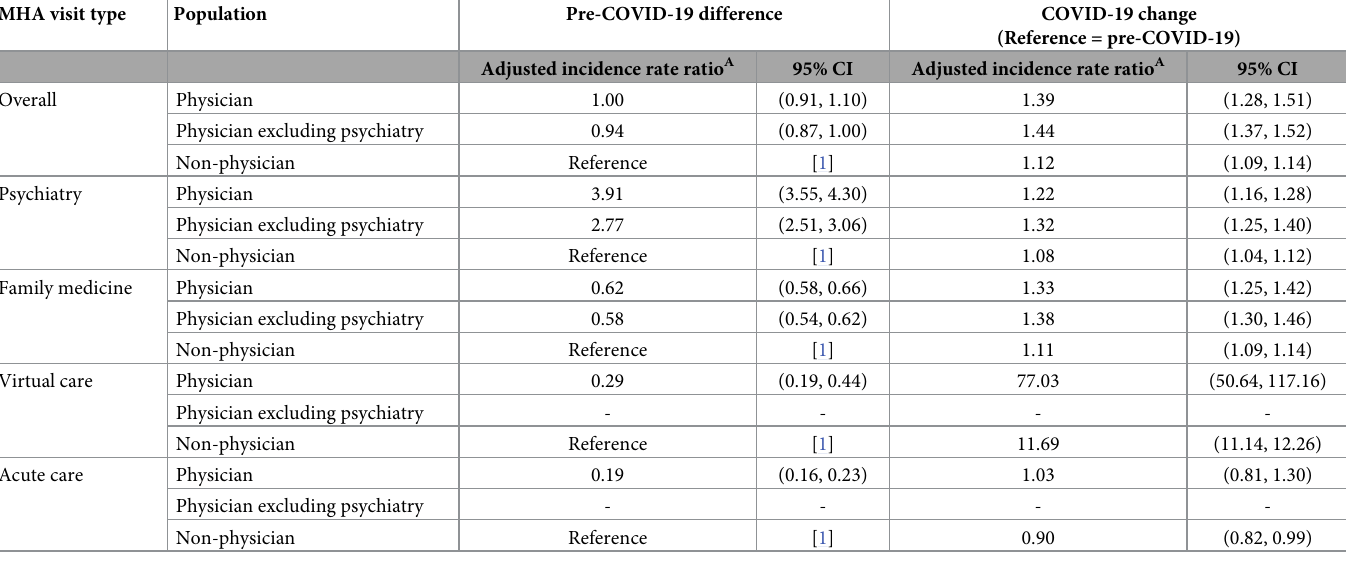
Table 3. Poisson regression models comparing differences pre–COVID–19 and changes during COVID–19 pandemic in MHA visits between physicians and non–